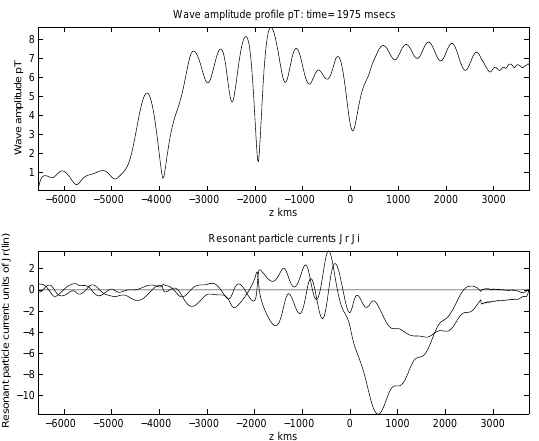
Fig. 4. Spectrogram of a weak termination faller produced by a 1 second pulse with linear equatorial growth rate of 30dB/s. Note the pronounced offset frequency ∼ 20Hz.